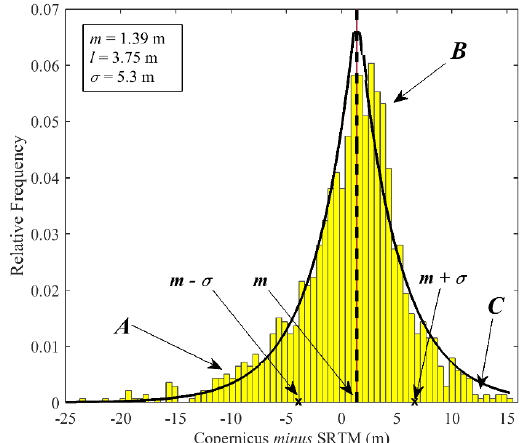
Figure 5 . Histogram of Copernicus minus SRTM difference for Spruce dominated stands. The Laplace pdf was calculated based on the actual DEMs differences and not on the histogram values.